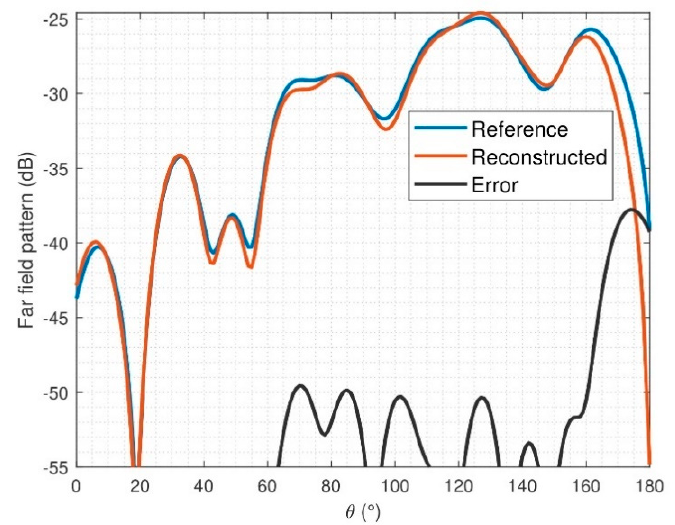
Figure 16. FF comparison after reconstruction of SH2000 for E θ , φ = 0°.